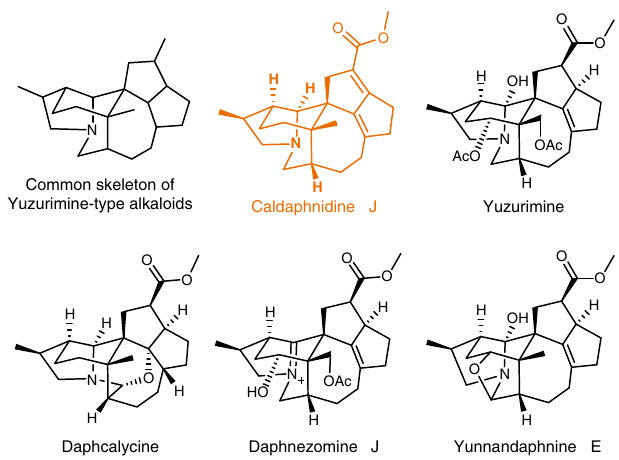
Fig. 1 Yuzurimine-type Daphniphyllum alkaloids. Our target molecule, caldaphnidine J, are highlighted in color, which posed a formidable synthetic challenge for accessing its total synthesis.